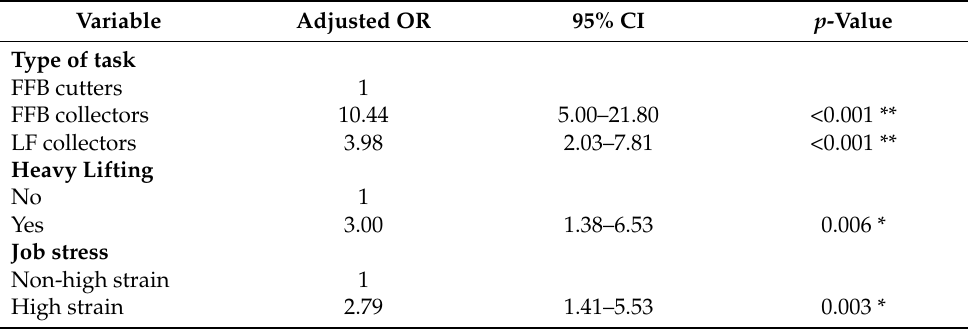
Table 4. Multivariate analysis of lower back MSDs during the past 12 months.